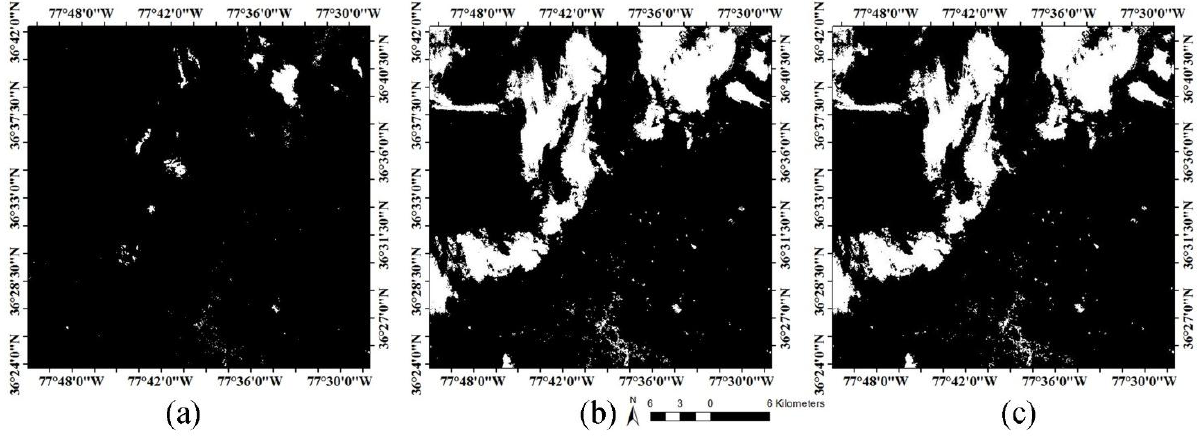
Figure 5. Cloud/non-cloud masks shown as a binary image with cloud being white and non- cloud as black. ( a ) The mask derived from QA Band, ( b ) the mask derived from the segmentation method, and ( c ) The mask after logical union operation of (a) and (b). (c) is used in the algorithm